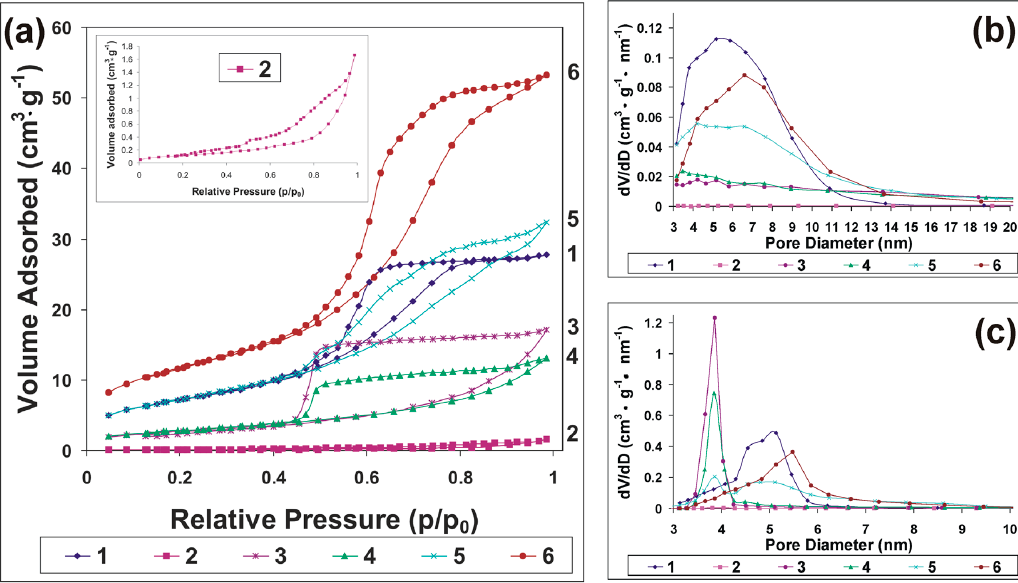
Figure 7. ( a ) N 2 adsorption-desorption isotherms for the synthesized hybrids (Inset: enlarged diagram of N 2 adsorption-desorption isotherm of Sample 2); ( b ) the corresponding BJH pore size distribution from the adsorption branch; ( c ) the corresponding BJH pore size distribution from the desorption branch.